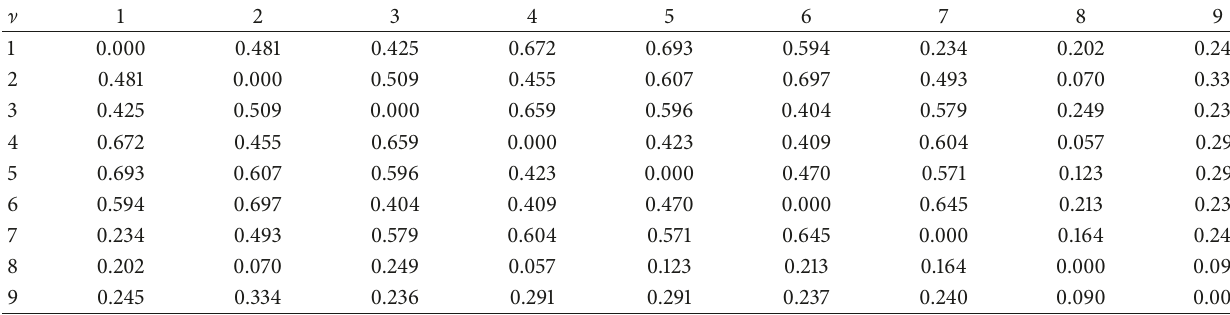
Table 12: Nonmembership parts of the intuitionistic fuzzy pairs, giving the intercriteria correlations.